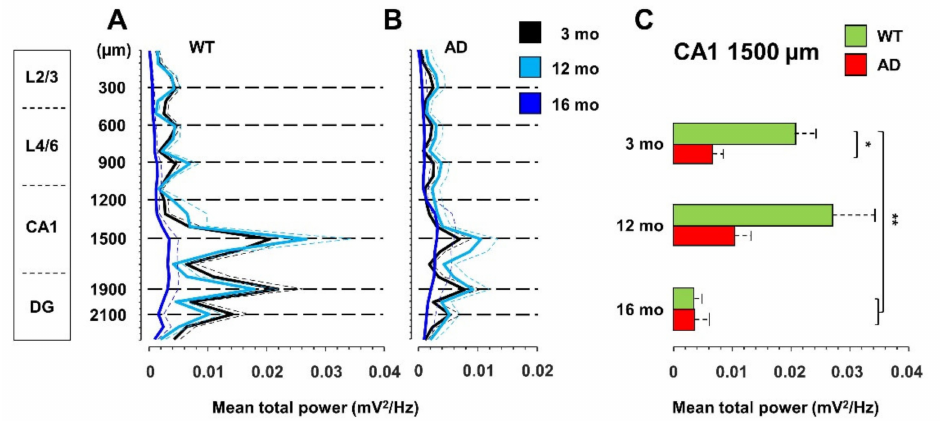
Figure 1. Total power is reduced in young AD and old WT mice. Total power (mean + SEM) profiles of LFP signals, recorded with a linear probe that crosses the PPC and HPF in WT ( A ) and AD ( B ) mice at different ages. The dotted horizontal lines indicate the depths of the seven channels used for all the subsequent analyses. ( C ) Histogram of the total power (mean + SEM) measured at CA1 sr-lm (1500 µ m) * p < 0.05; ** p < 0.01, numbers of mice: WT 13, 10, 7 and AD 16, 10, 7 at 3, 12 and 16 months of age, respectively.